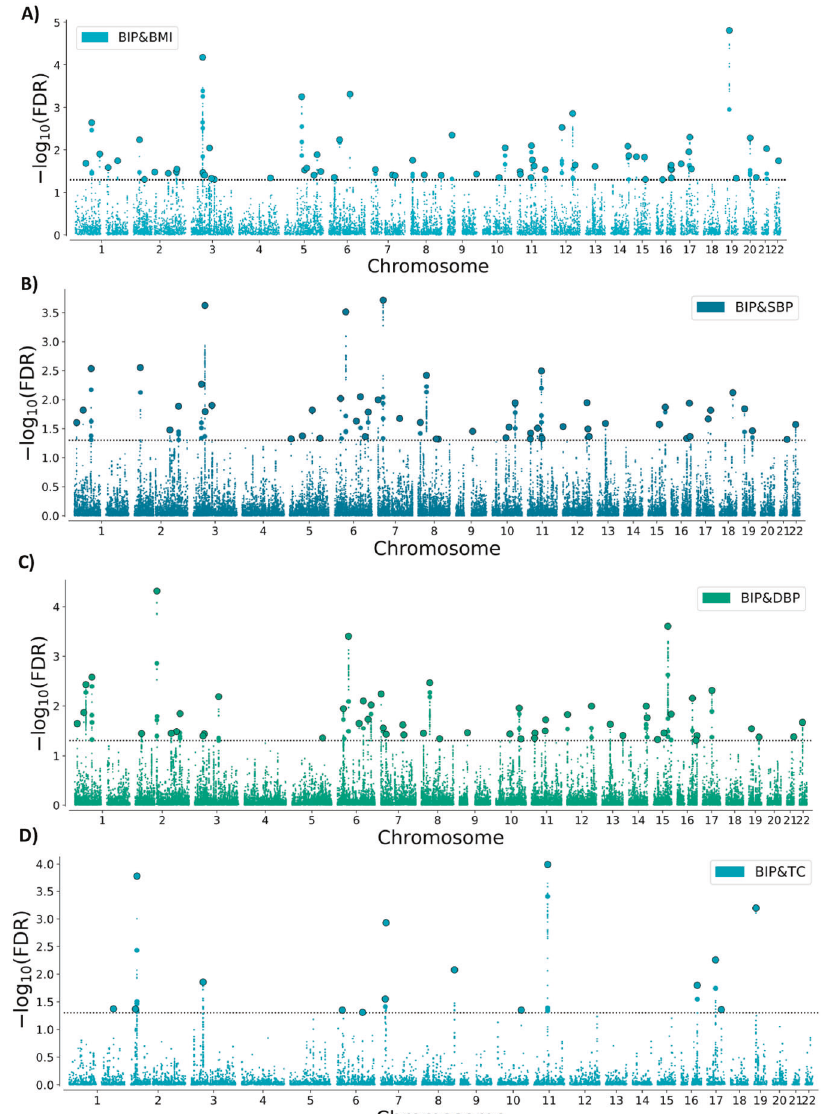
Fig. 2 Common genetic variants jointly associated with bipolar disorder and cardiovascular disease phenotypes at conjFDR<0.05. Common genetic variants associated with both BIP and ( A ) BMI, ( B ) SBP, ( C ) DBP, ( D ) TC, ( E ) LDL, ( F ) HDL, ( G ) T2D, and ( H ) CAD at conjFDR<0.05. Manhattan plot showing the – log10 transformed conjFDR values for each SNP on the y -axis and chromosomal positions along the x -axis. SNPs with conjunction FDR<0.05 (i.e., − log10 FDR>1.3) are shown with enlarged data points. A black circle around the enlarged data points indicates the most signi fi cant SNP in each LD block. Further details are provided in Supplementary Tables. BIP bipolar disorder, CVD cardiovascular disease, BMI body mass index, SBP systolic blood pressure, DBP diastolic blood pressure, TC total cholesterol, LDL